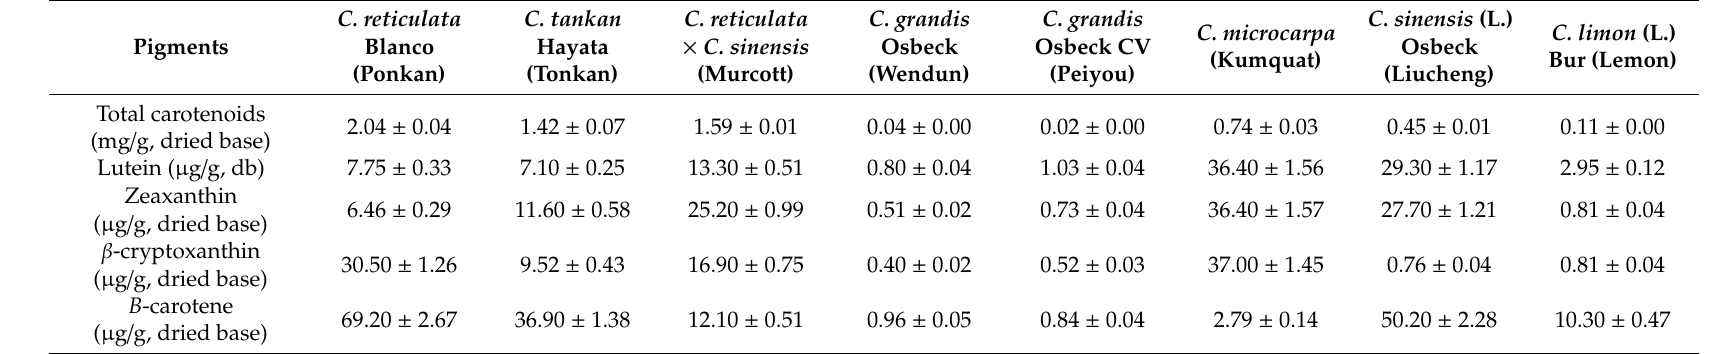
Table 8. Composition of pigments determined from the peels of di ff erent citrus varieties grown in Taiwan